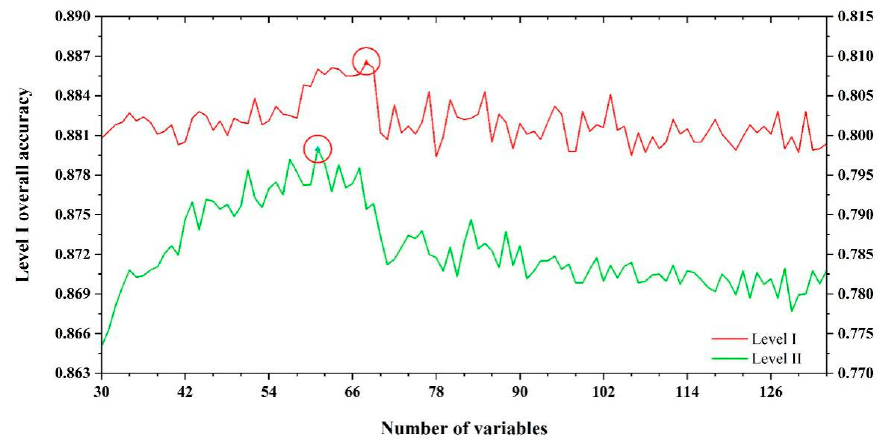
Figure 7. A spatial distribution of ( a ) the original POI points and ( b ) the regenerated POI points.